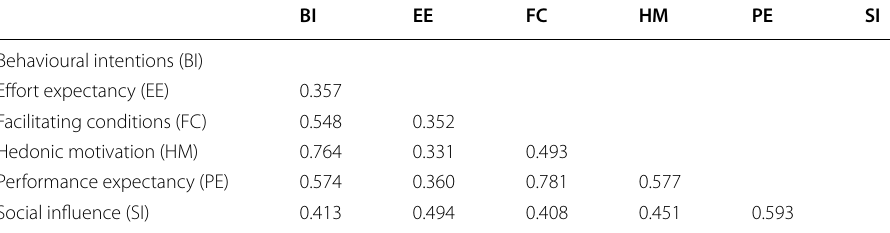
Table 3 Heterotrait‑Monotrait ratio (HTMT) measure of discriminant